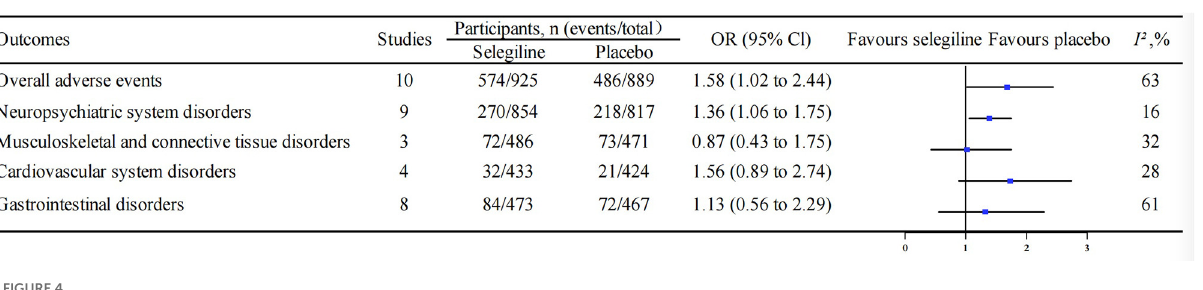
sensitivity analysis was performed after eliminating this study. The heterogeneity was reduced (total UPDRS: MD − 1.14, 95% CI − 2.91 to 0.63, P = 0.21, I 2 = 81%; UPDRS II: MD − 0.46, 95% CI − 0.77 to − 0.14, P = 0.005, I 2 = 0%; UPDRS III: MD − 2.97, 95% CI − 6.63 to 0.68, P = 0.11, I 2 = 78%). The results showed no